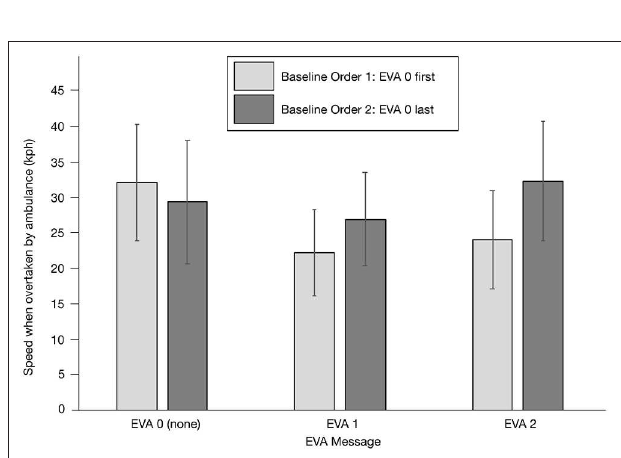
FIGURE 3 | Mean speed ( ± SE) when overtaken by the ambulance, by Baseline Order and EVA